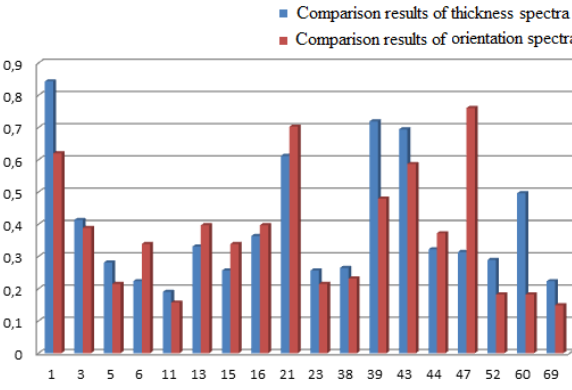
Figure 11: Average precision when comparing spectra with EMD-L 1